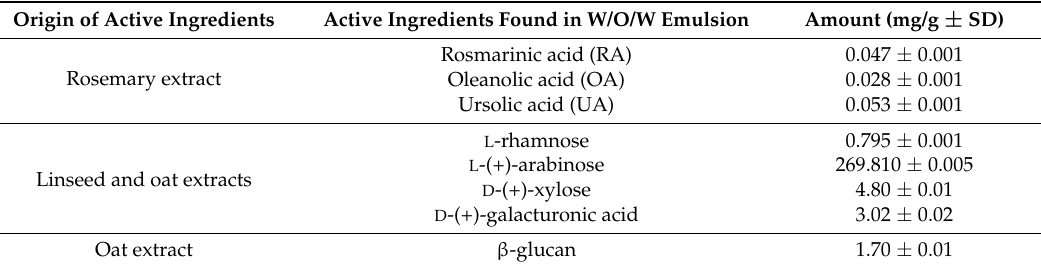
Table 1. Phytochemical composition of multiple emulsion.